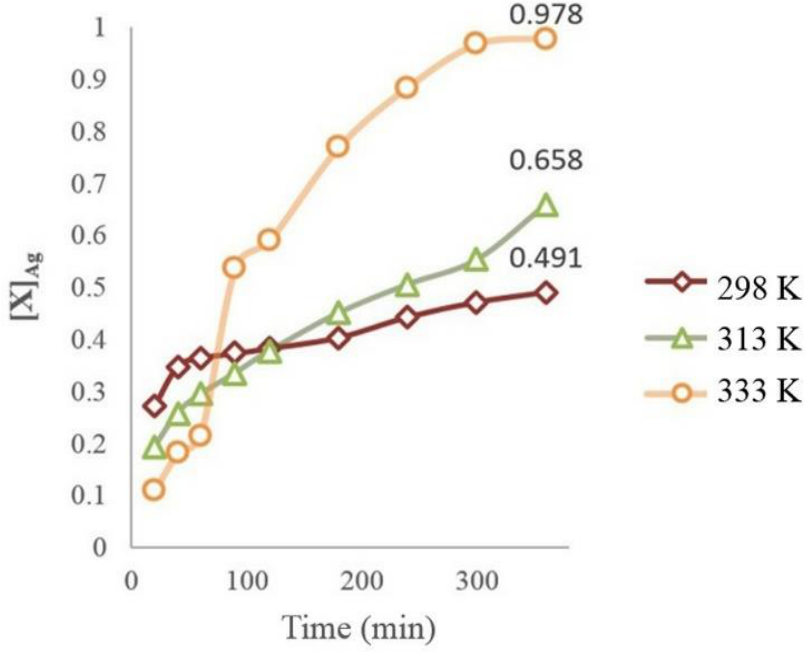
Figure 8. Representation of the effects on the leaching temperature of silver.